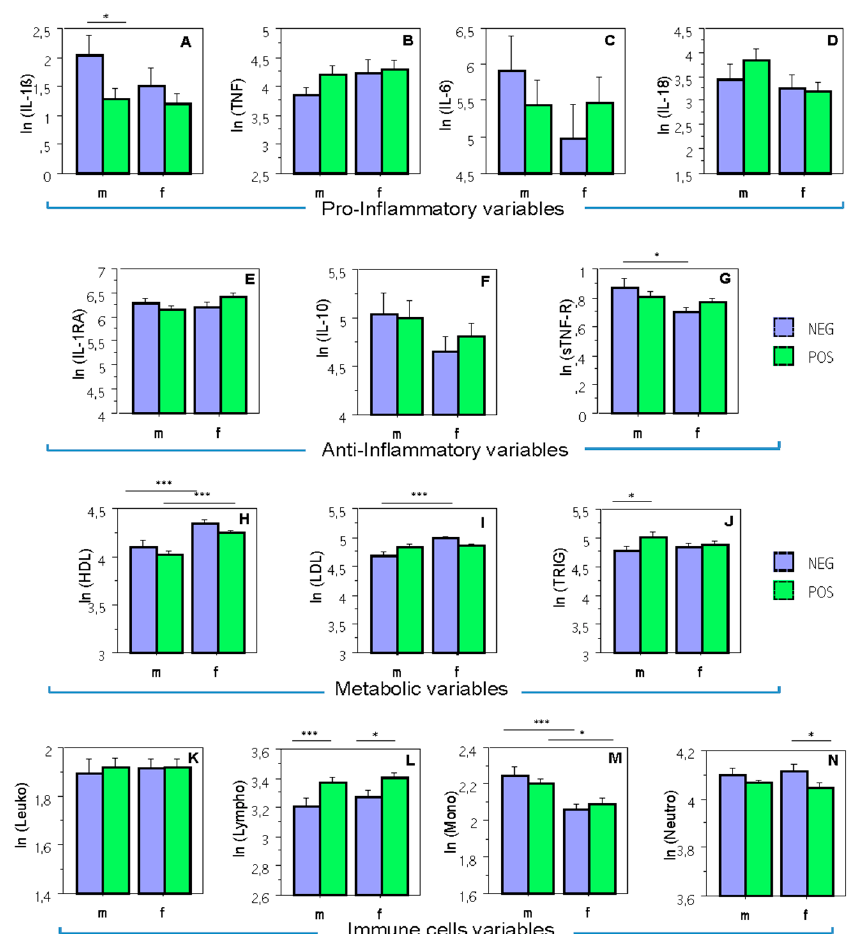
Figure 2. Means and standard errors for all dependent variables by Sex and CMV. Diagrams of concentrations (logarithmically transformed) for: ( A – D ) pro-inflammatory variables; ( E – G ) anti-inflammatory variables; ( H – J ) metabolic variables; ( K – N ) immune cells. IL: interleukin; IL-1 β : interleukin 1 beta; TNF: tumor necrosis factor; IL-1RA: interleukin 1 receptor antagonist; sTNF-R: soluble tumor necrosis factor receptor; HDL: high-density lipoprotein; LDL: low-density lipoprotein; m: male; f: female; POS: NEG: CMV-seronegative CMV-seropositive; ln: natural logarithm. *, p < 0.05; ***, p <